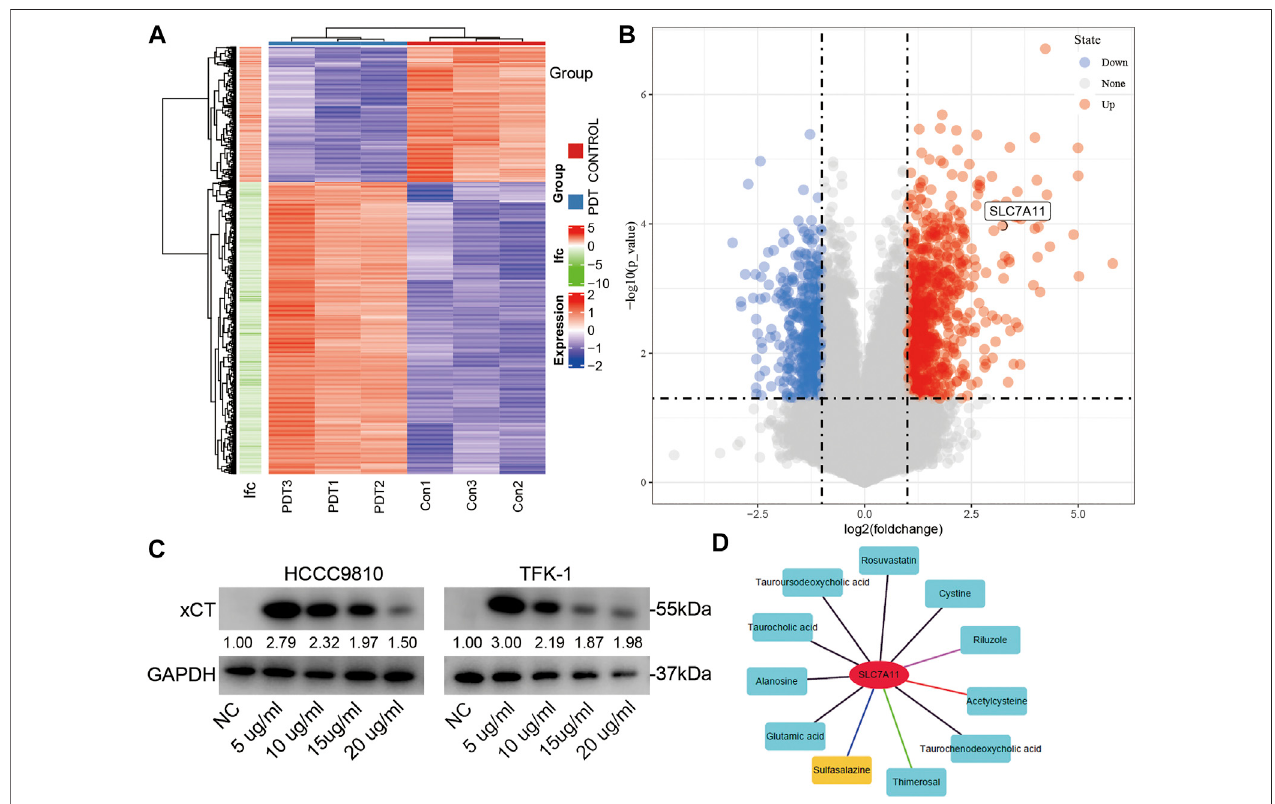
FIGURE3| TheexpressionofxCTchangesafterPDTtreatment. (A,B) TheheatmapandvolcanomapofthedifferentialgenesafterPDTtreatment;xCT( SLC7A11 ) is marked. (C) After treatment with different concentrations of PHP-PDT, the expression of xCT in HCCC-9810 and TFK-1 cells was different. (D) Potential drug targets of